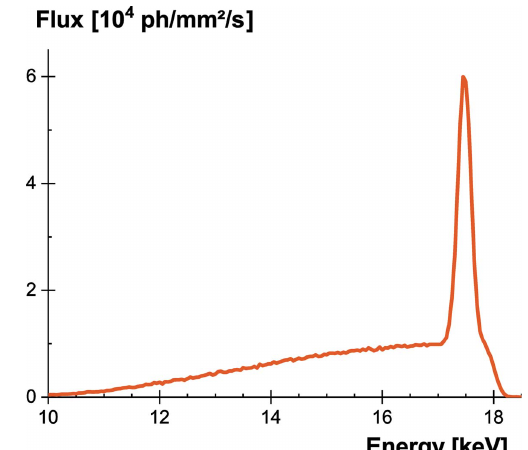
Figure 3 Flux and energy of generated X-rays with a molybdenum anode and a 100 m m zirconium filter, measured at a distance of 125 cm.